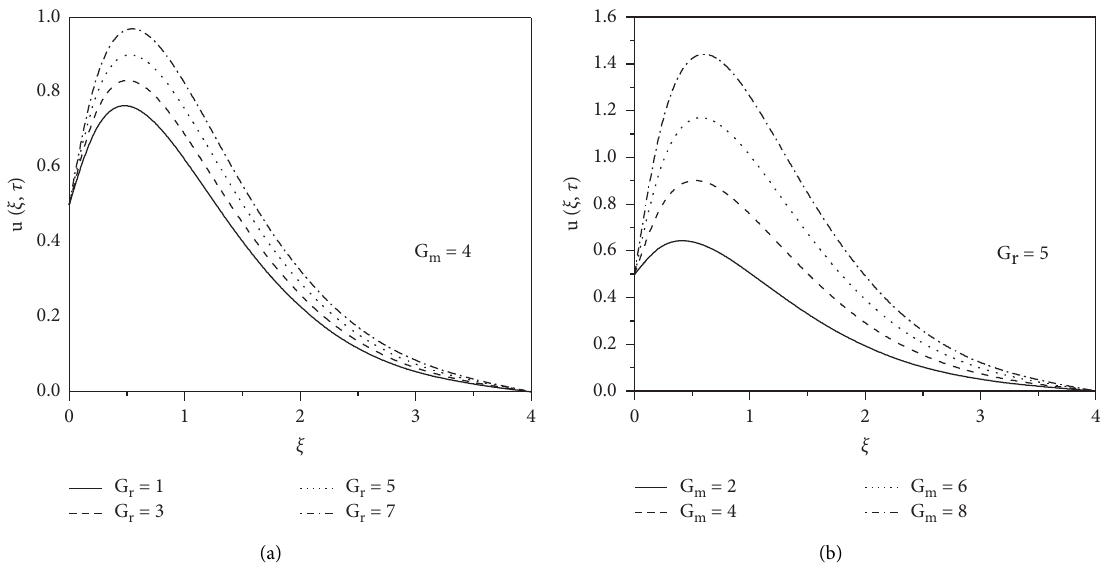
Figure 9: Variation of velocity u ( ξ , τ ) against ξ for various values of (a) G